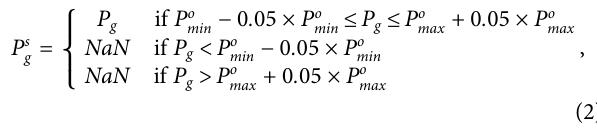
Frontiers in Earth Science |